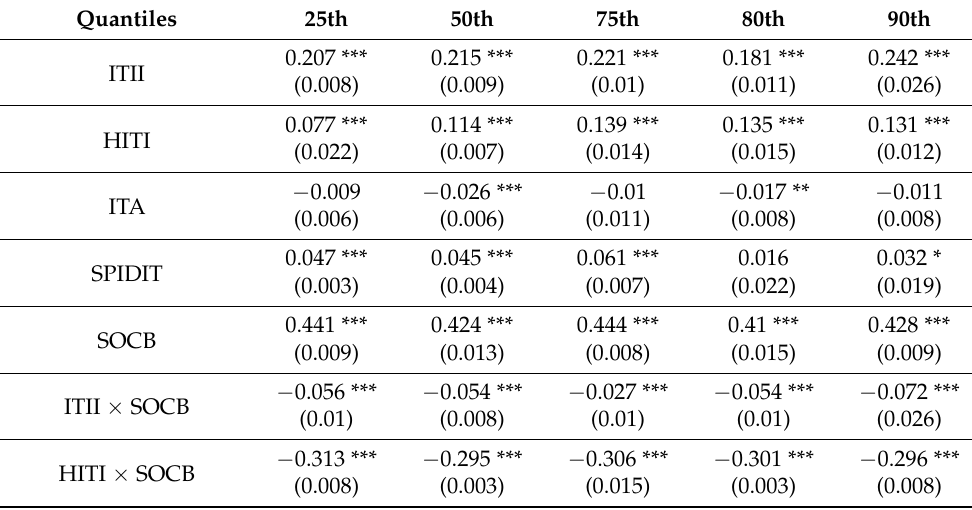
Table 6. The results of interaction terms between ICT components and bank ownership.